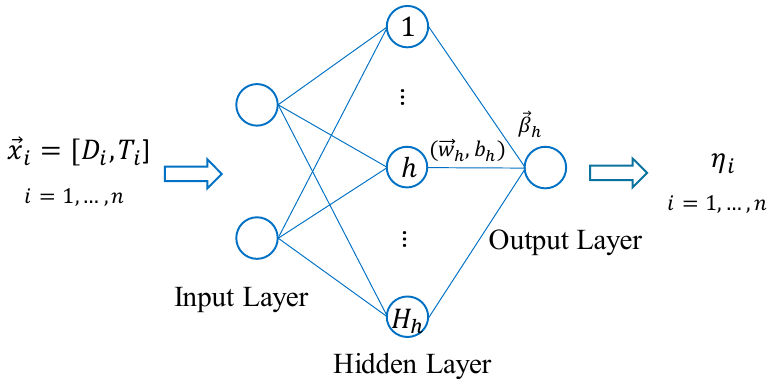
Figure 3. The artificial neural network (ANN) architecture with two inputs, one hidden layer, and one output.